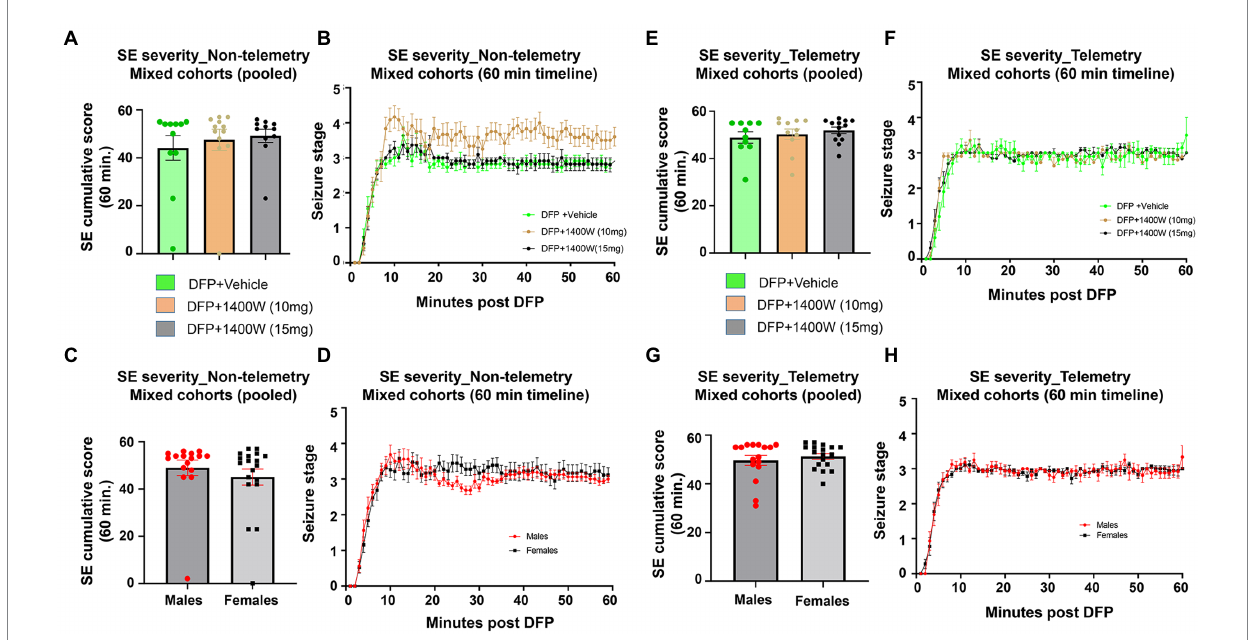
FIGURE 2 SE severity quantification during the 60 min post DFP in non-telemetry and telemetry groups. There were no significant differences in the SE severity between the vehicle and 1400W treated groups in both sexes. One-way ANOVA with Tukey’s post-hoc for multiple comparisons ( A,B ; n = 11–12), ( C,D ; n = 16–19), ( E,F ; n = 10–13), and ( G,H ; n =